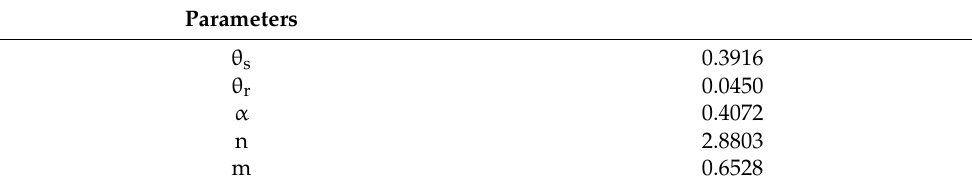
Table 1. Parameters of the van Genuchten equation for a soil depth of 0.15 m, Paraipaba-CE,